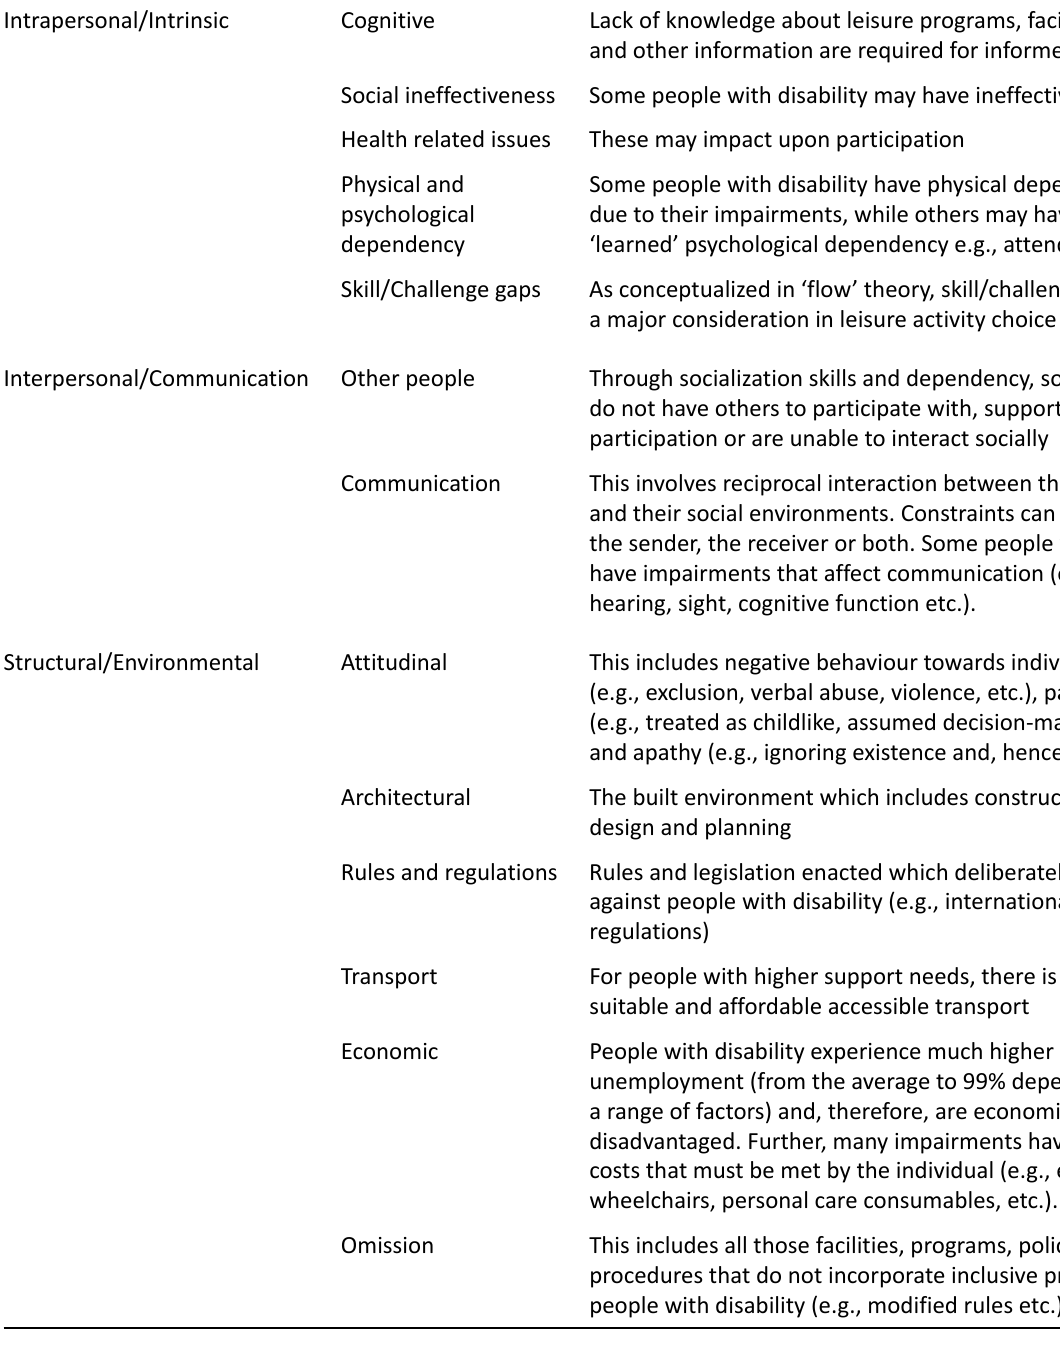
Table 1. Leisure constraints for people with disability reinterpreted from Smith et al. (2005).